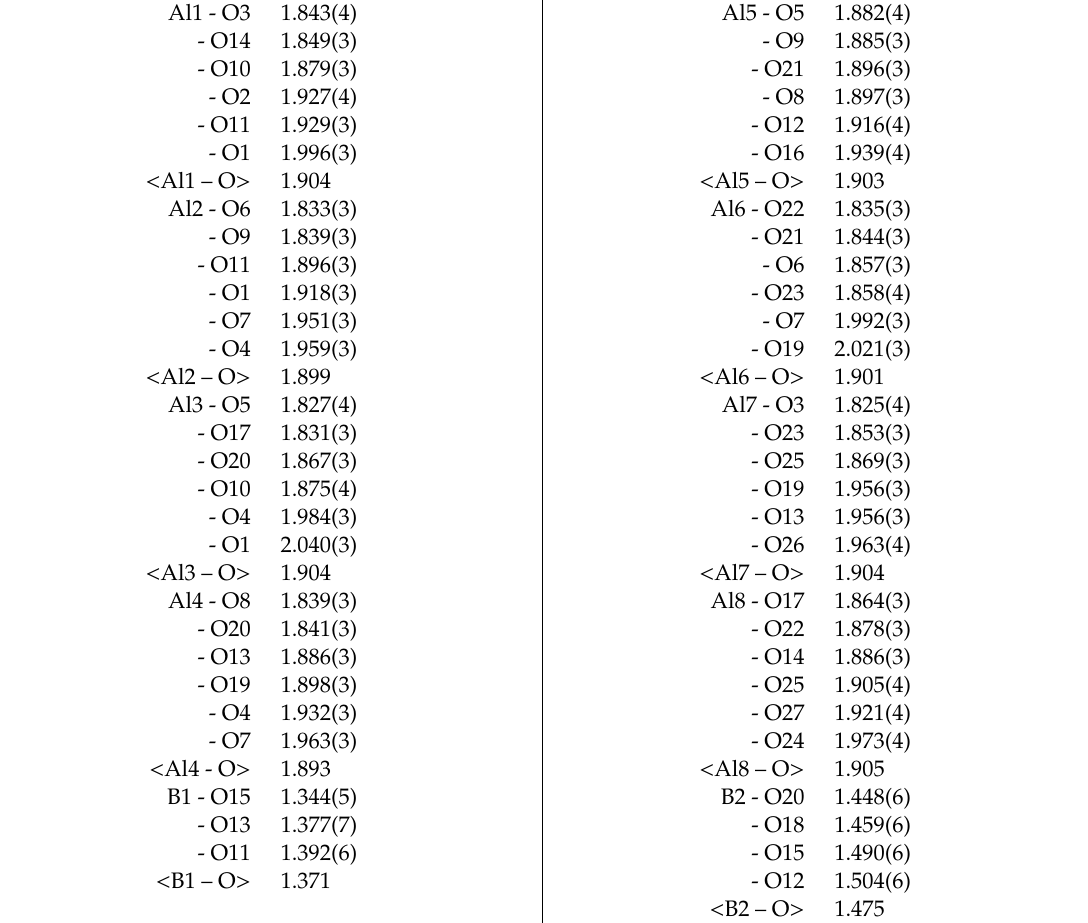
Table 4. Selected interatomic distances (Å) in the structure of krasnoshteinite.